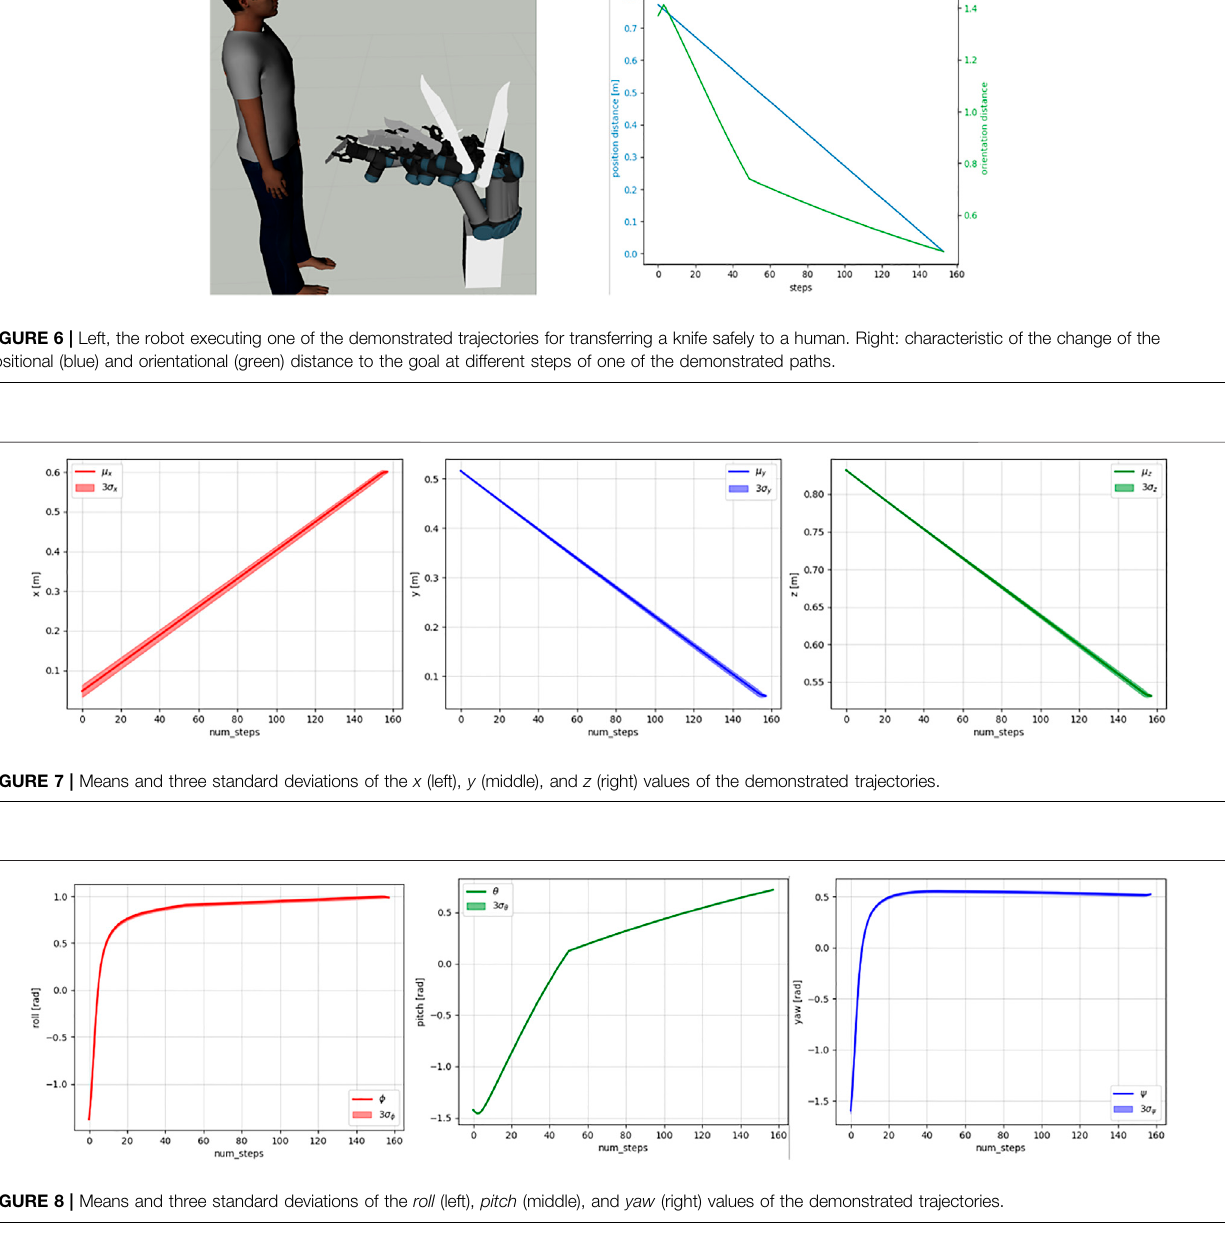
Frontiers in Robotics and AI |